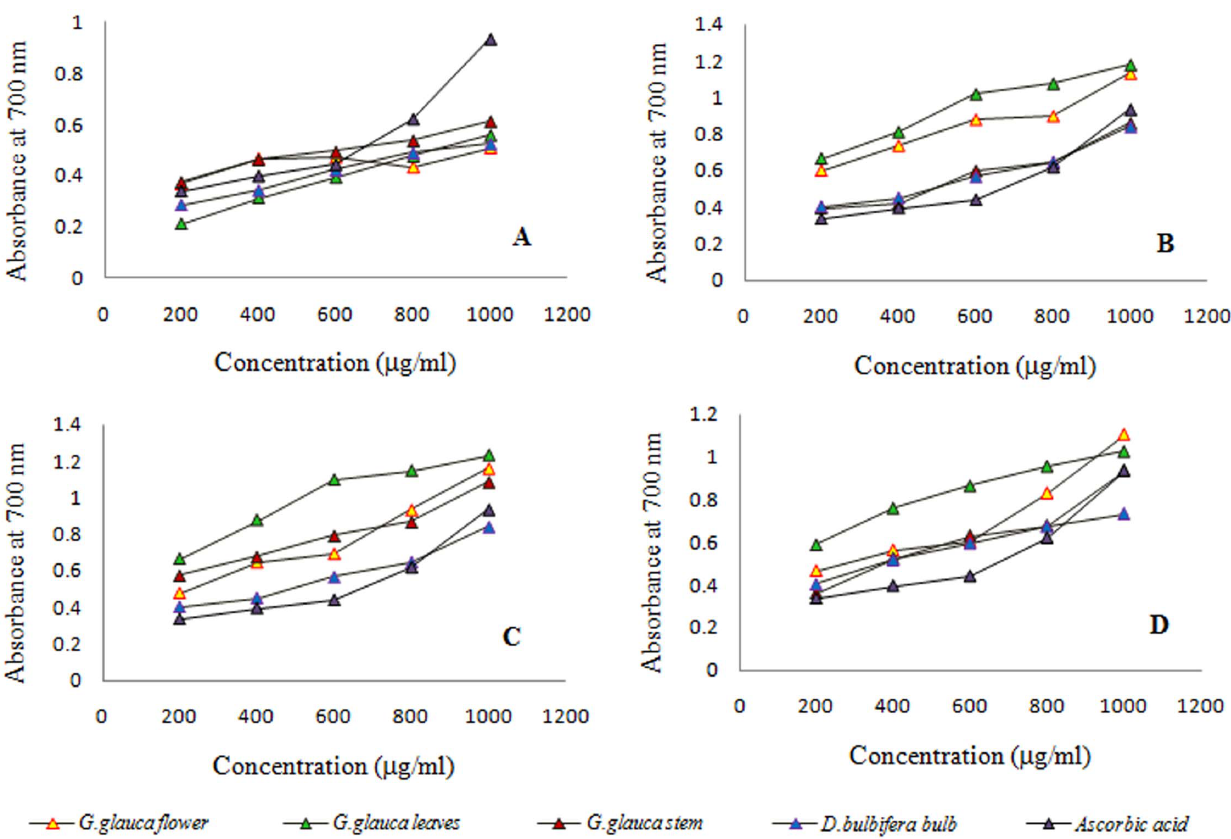
Figure 5. Reducing activity of plant extracts. (A) Petroleum ether extract, (B) Ethyl acetate extract, (C) Methanol extract, (D) Ethanol (70% v/v) of plants at various concentrations.